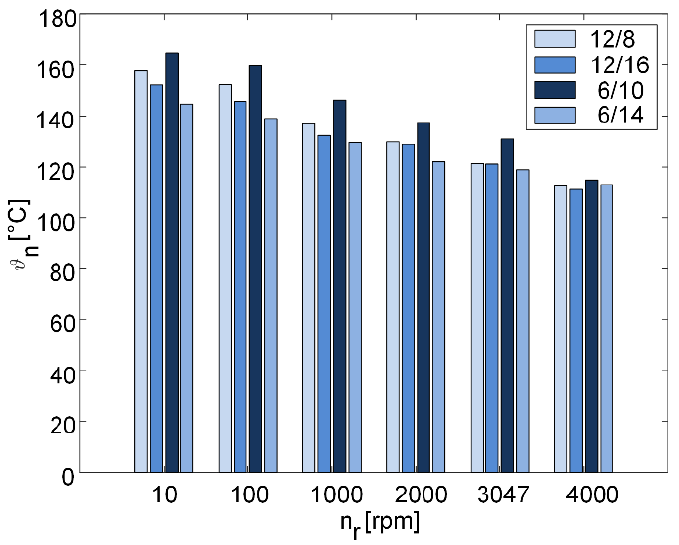
Figure 22. Maximum temperature in the motor after 1 h operation at nominal current for different SRM configurations.